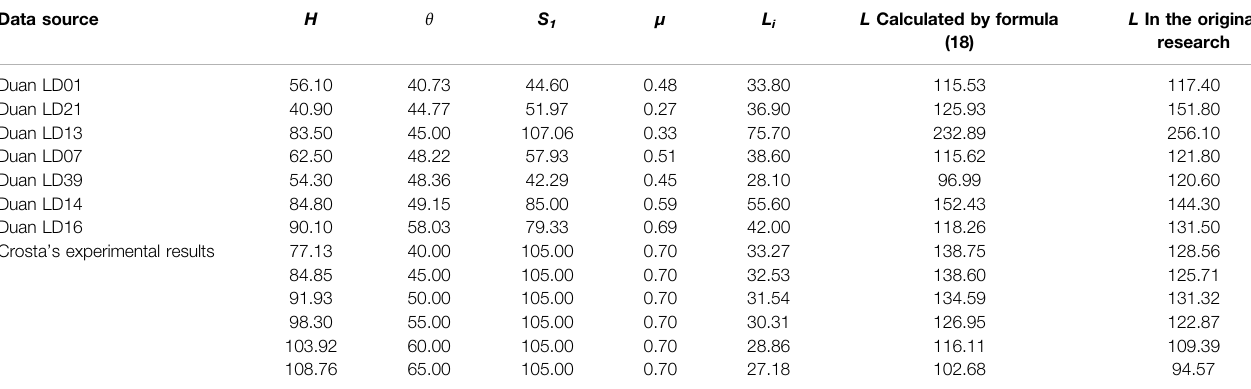
TABLE 1 | Summary of properties for the landslides from reality and experiments. Data